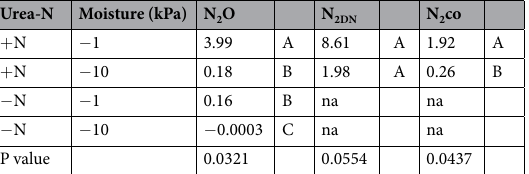
Table 1. Mean cumulative N 2 O, N 2DN and N 2 co emissions (g N m − 2 ). P values are for the interaction between treatments. Tukey-Kramer grouping: LS-means with the same letter are not significantly different, na not